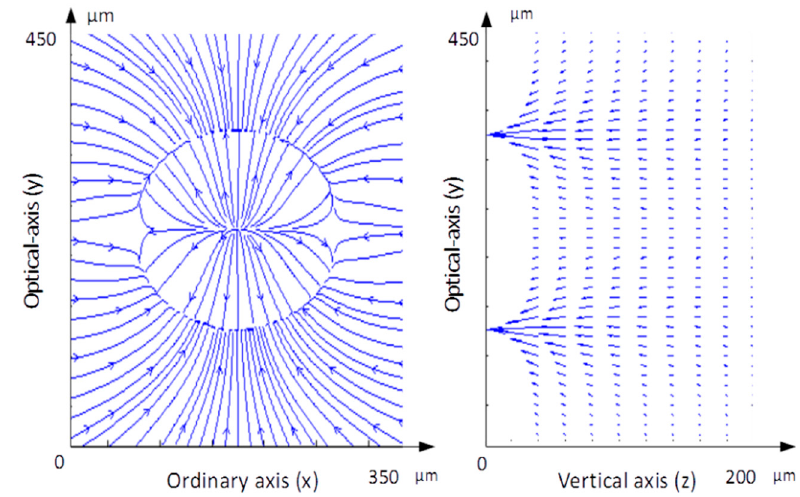
Figure 4. Simulation of the dielectrophoretic (DEP) force in the x-z layer 1 µm above the sample surface and in the y-z layer for x = 175 µm.